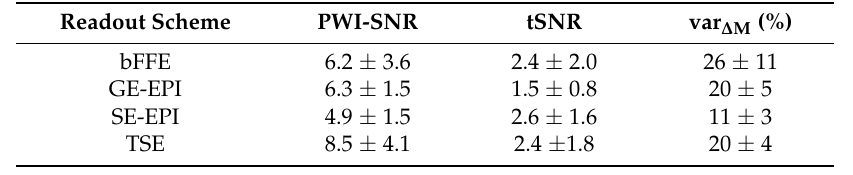
Figure 3. Example perfusion-weighted images (PWI) for each scheme (bFFE, GE-EPI, SE-EPI, and TSE) from a single subject. The post-label delay of each slice is indicated on each image.